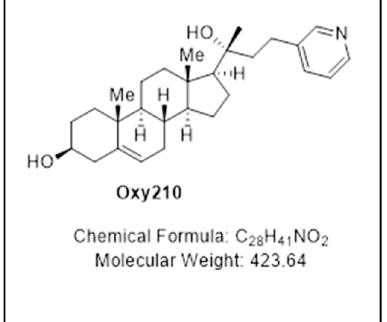
Figure 1. Molecular structure, chemical formula, and molecular weight of Oxy210.